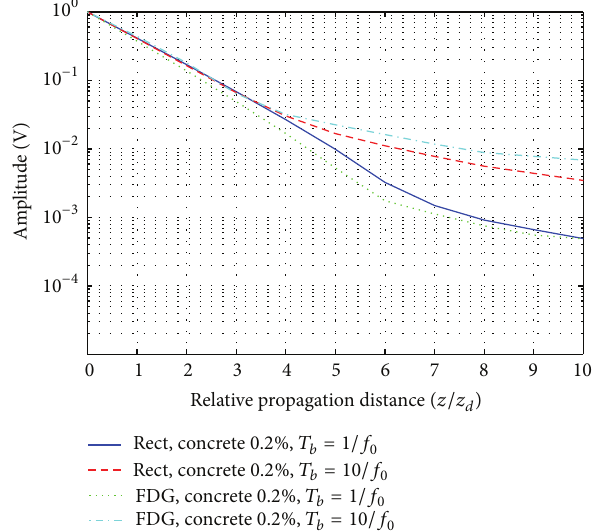
Figure 9: Peak amplitude as a function of propagation distance through dry concrete (0.2% moisture) for rectangular and FDG pulses of duration 𝑇 𝑏 = 10/𝑓 0 and 𝑇 𝑏 = 1/𝑓 0 at 𝑓 0 = 1.5 GHz.